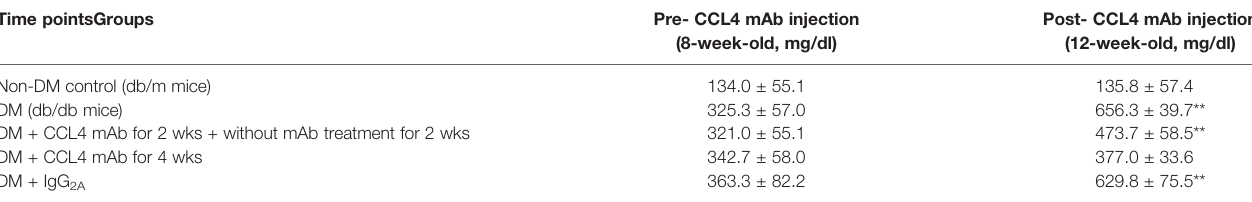
TABLE 3 | Blood sugar levels in db/db mice. Time pointsGroups